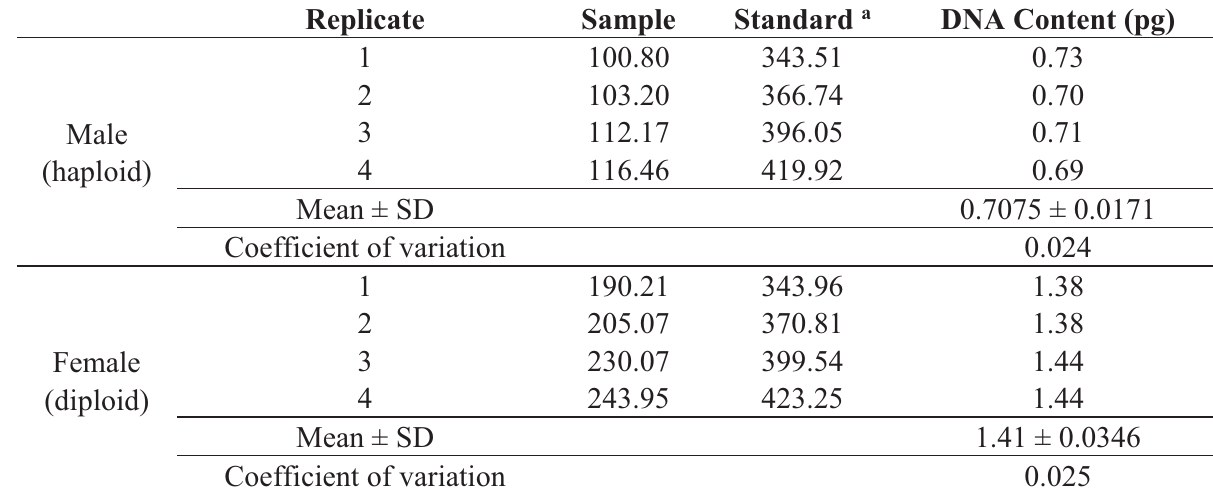
Table 2. Flow cytometric estimation of nuclear DNA content of Bemisia tabaci MEAM1 .